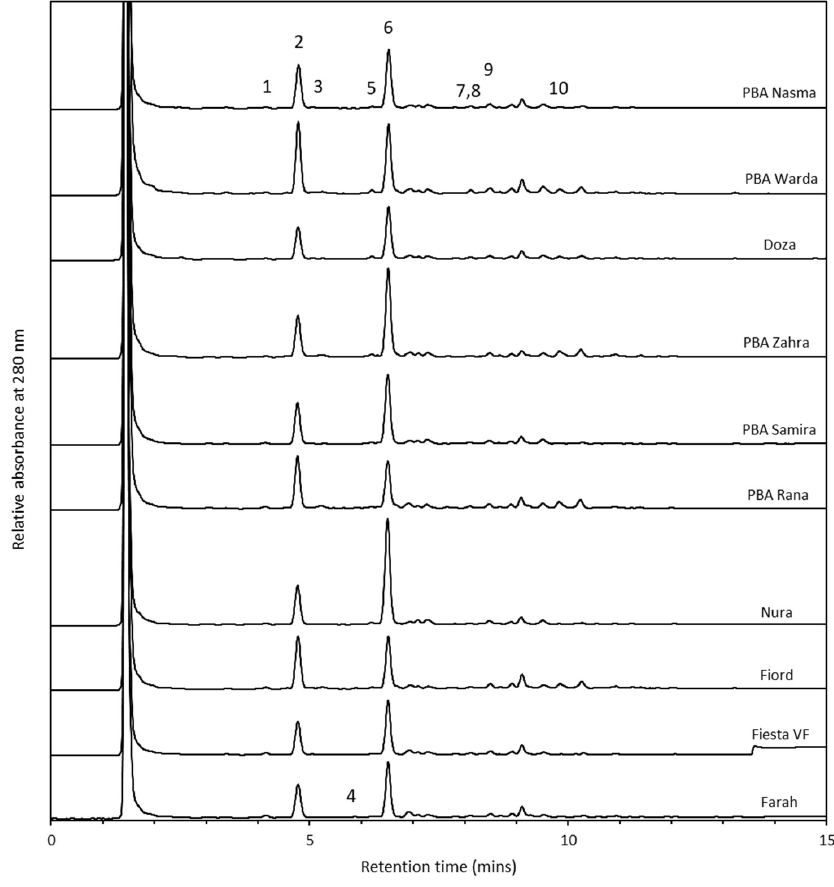
Figure 2. HPLC chromatograms of the phenolic compounds in the 10 faba bean varieties. The com- pounds indicated are (1) protocatechuic acid, (2) catechin, (3) chlorogenic acid, (4) p -hydroxybenzoic acid, (5) vanillic acid, (6) syringic acid, (7) p -coumaric acid, (8) vitexin, (9), trans -ferulic acid, (10) rutin.